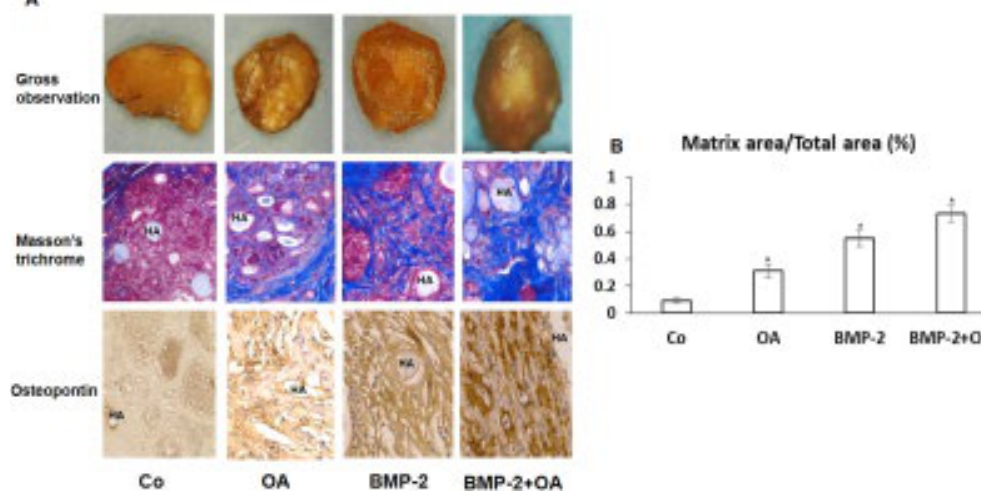
Figure 4. OA treatment enhances MSC ectopic bone formation in vivo . ( A ) Top panel: Gross observation of transplanted MSC/HA pellet immediately after fixation. Middle panel: Masson’s Trichrome staining of tissue sections from the ectopic ossicle formation samples at 6 weeks after implanted with MSCs that were previously mixed with OA and/or BMP2. Blue staining denotes a Col1a1 rich bone-like matrix in the ossicles. Low panel: Immunohistochemistry staining of osteopontin in transplanted MSC/HA pellet. ( B ) Areas of bone-like matrix (blue) staining on Masson’s Trichrome stained sections were quantified vs total area using ImageJ for all groups ( n = 3; magnification, ×